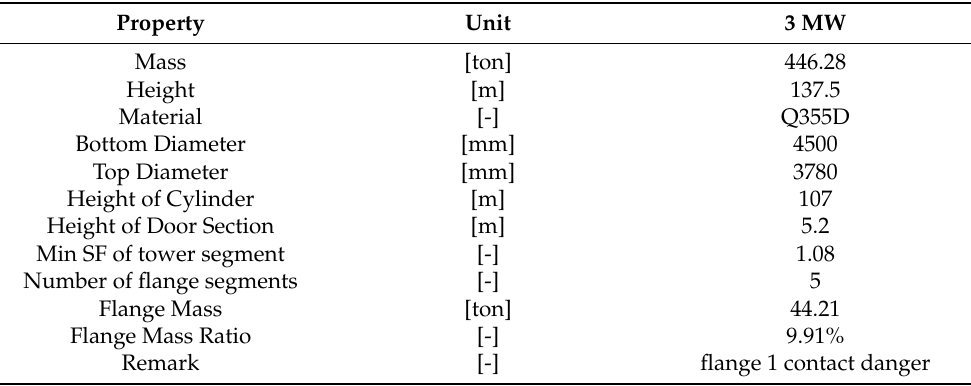
Table 1. Basic property of the original 3 MW